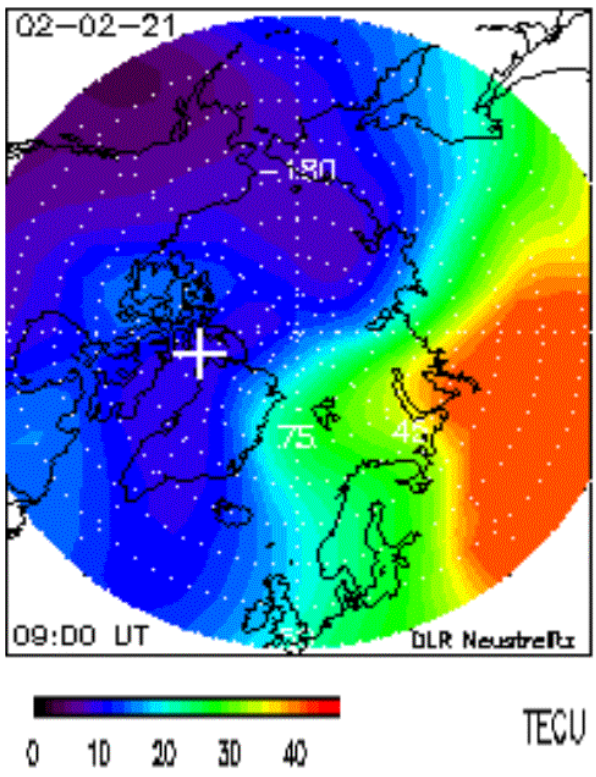
Fig. 3. TEC obtained using IGS network data over the Northern Hemisphere for times close to the occultation event at 21 February 2002. (1 TECUnit=1 × 10 16 electrons/m 2 ).